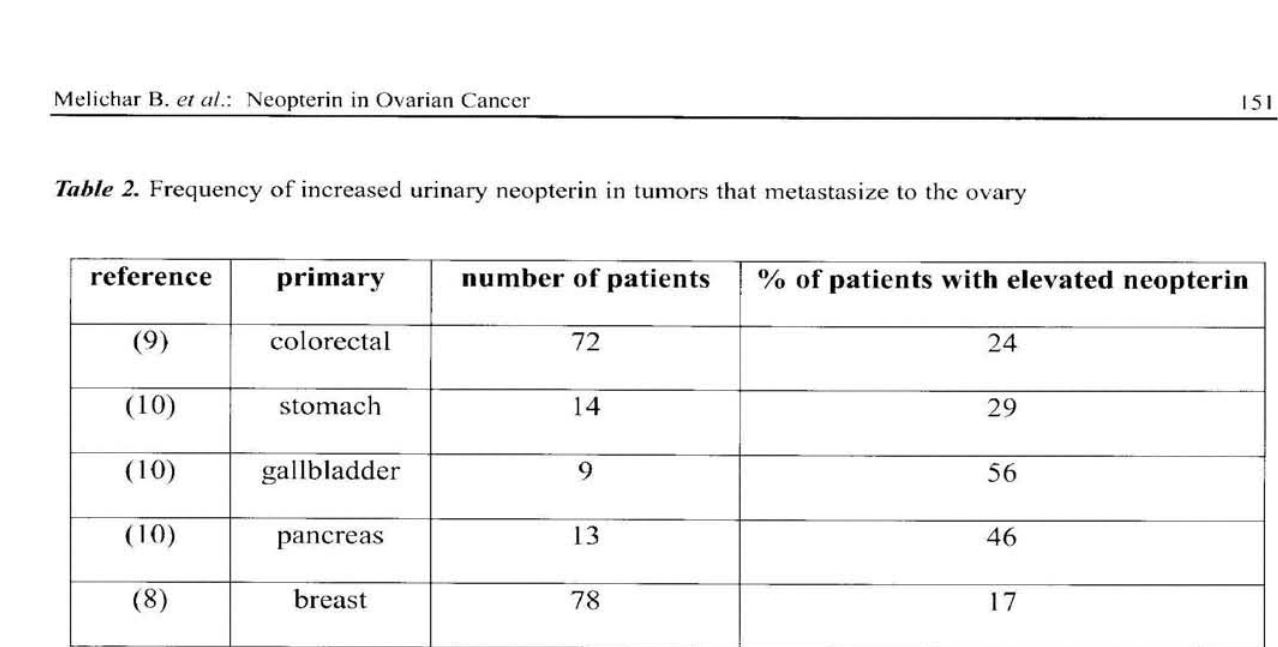
Table 2. Frequency of increased urinary neopterin in tumors that metastasize to the